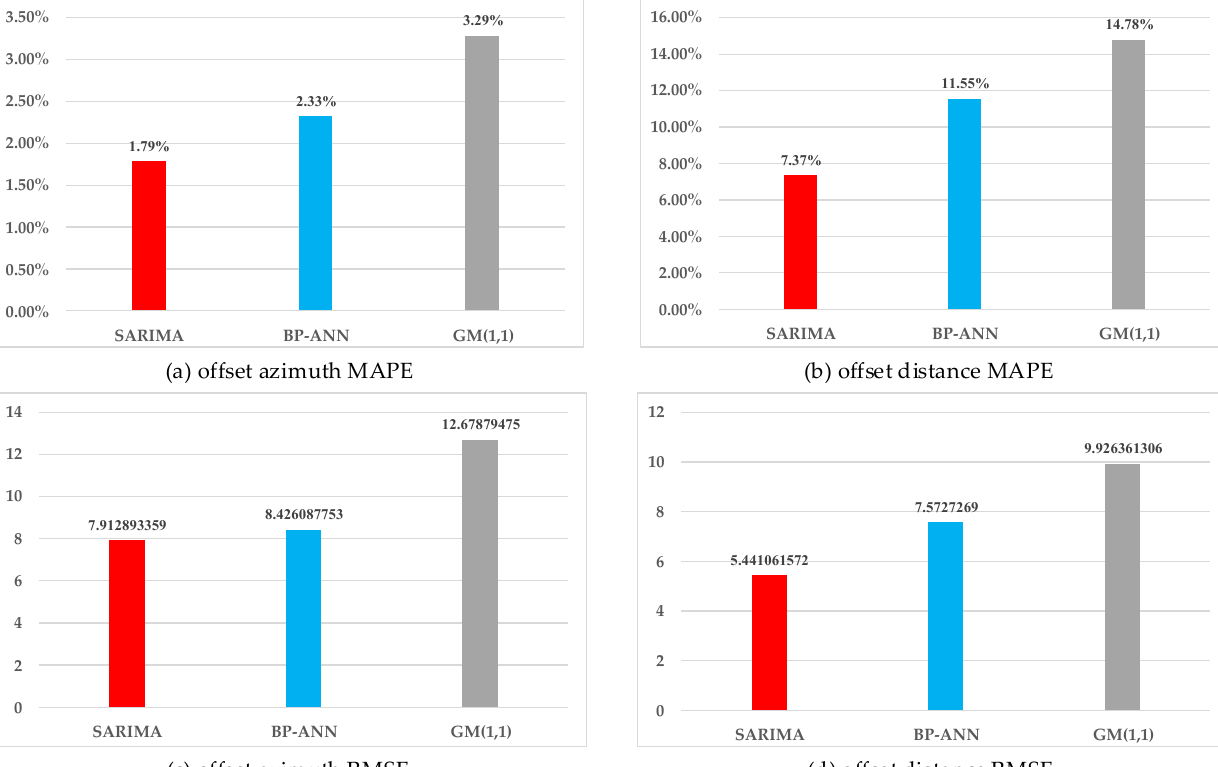
Figure 20. Error analysis.